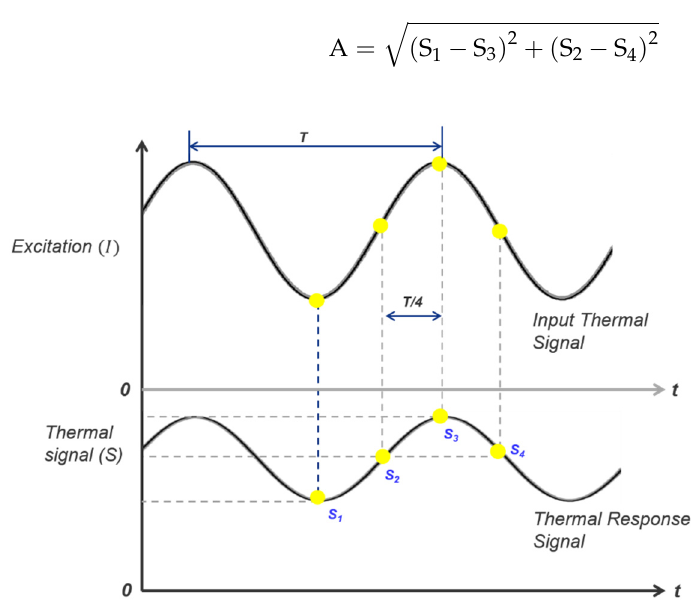
Figure 1. Principle of the four-point method in lock-in thermography.